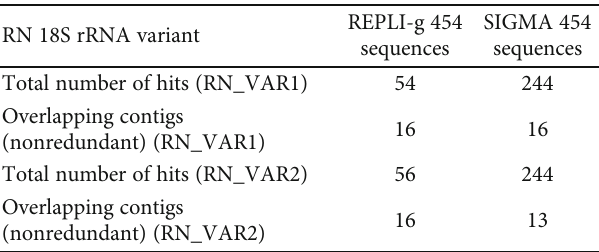
Table 4: Summary of blast hits among reniform nematode 18S variants and 454 genomic sequences.